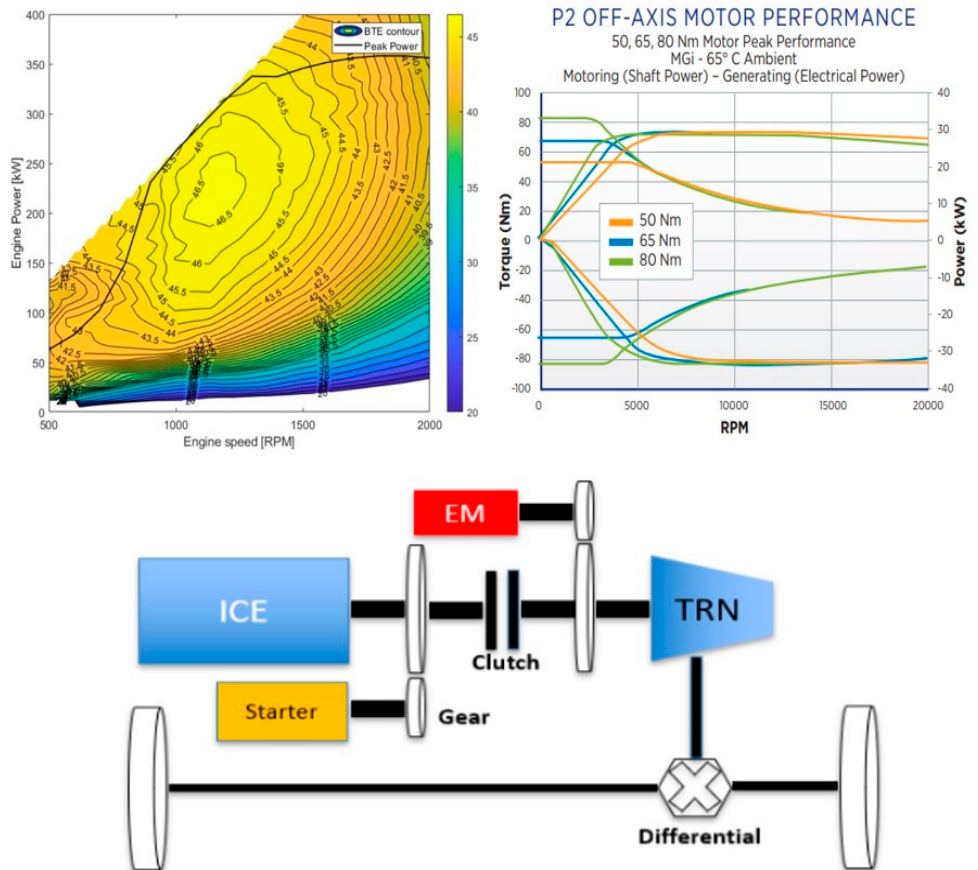
Figure 1. Powertrain design [29,30].